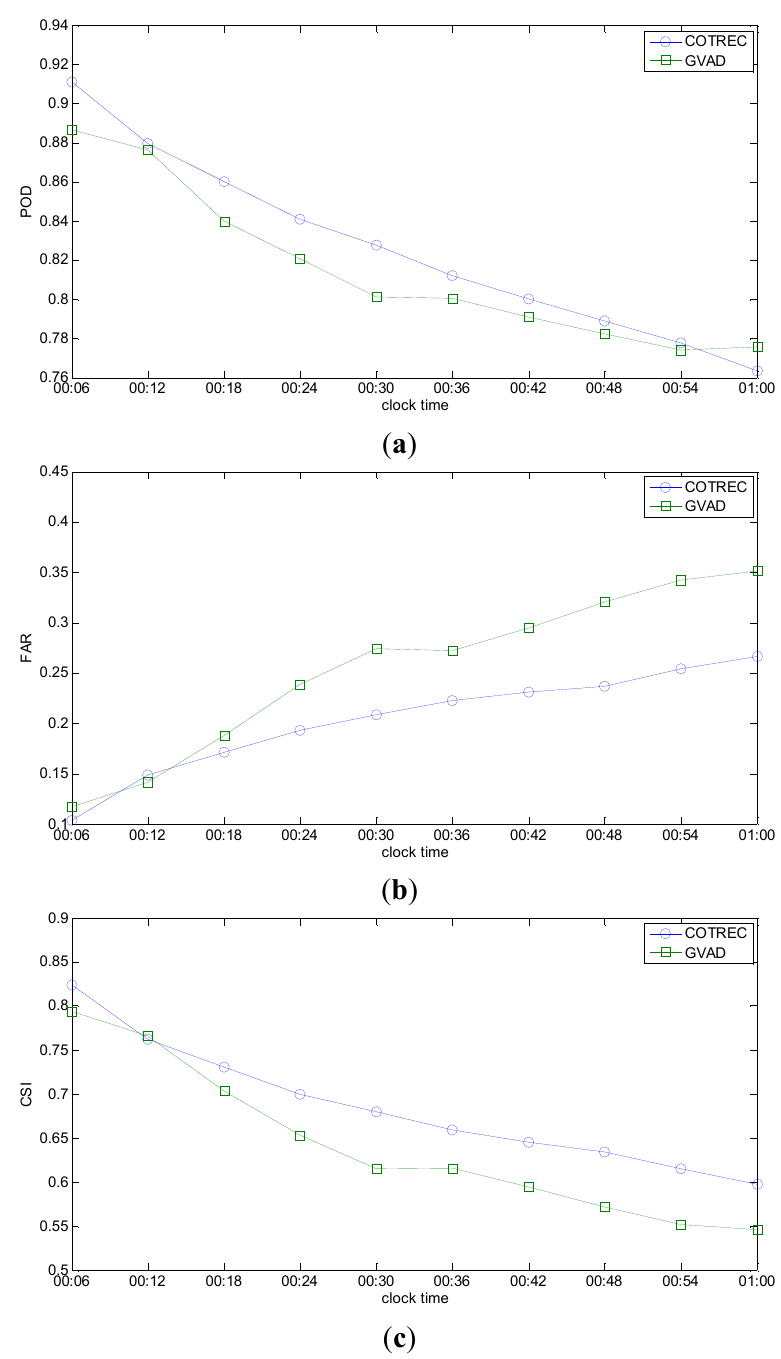
Figure 8. Testing of the Nanjing case for each 6 min from 00:06 to 01:00 (UTC) on 12 July 2010. ( a ) POD; ( b ) FAR; ( c )